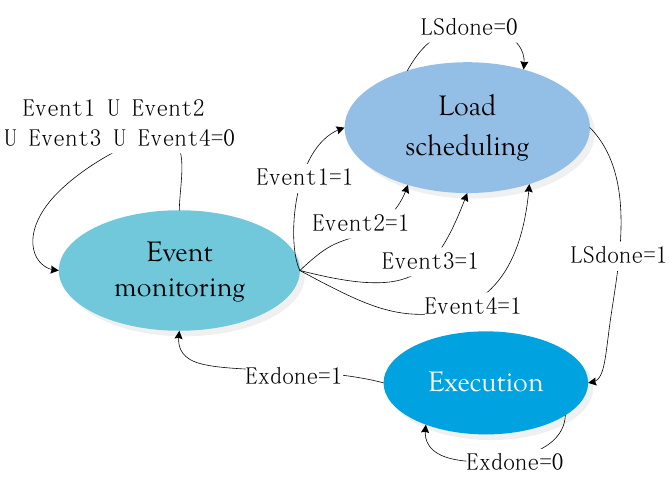
Figure 2. Diagram of the event-triggering